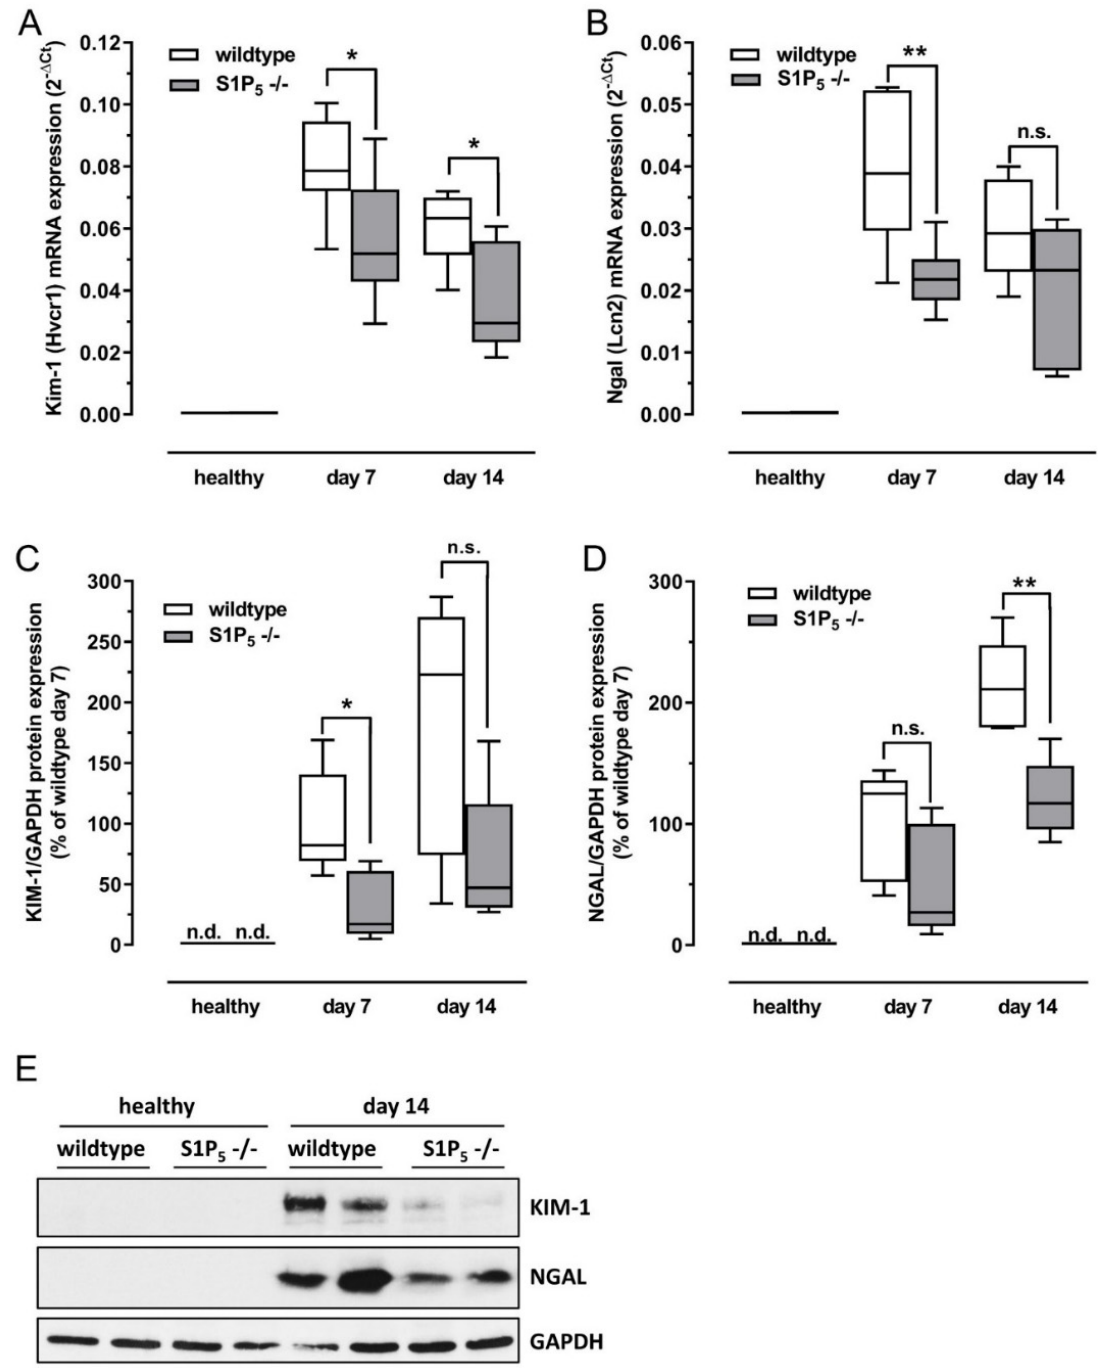
Figure 3. Expression of tissue damage markers in kidney homogenates of healthy mice and mice fed with an adenine-rich diet for the indicated time periods. The expression was compared between wild-type mice (C57BL/6J) and S1P 5 knockout mice (S1P 5-/- ). ( A , B ) Expression of Kim-1 and Ngal mRNA determined by TaqMan ® analysis as described in Materials and Methods. The internal standard used was 18 s ribosomal RNA. ( C – E ) Representative Western blot ( E ) and quantification of all Western blot results from kidney lysates employing antibodies for KIM-1 ( C ) and NGAL ( D ). Data are shown as box plots with a line at the median and whiskers from minimum to maximum value; n = 5–9; n.d. = no protein band detected; n.s. = not significant; * p ≤ 0.05; ** p ≤ 0.01 as